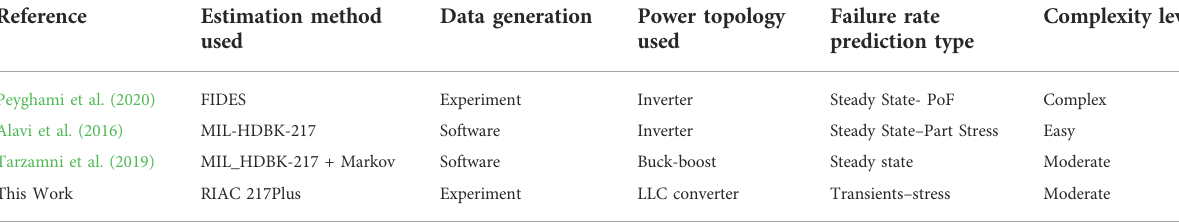
TABLE 4 Reliability prediction of power electronics converters by using different